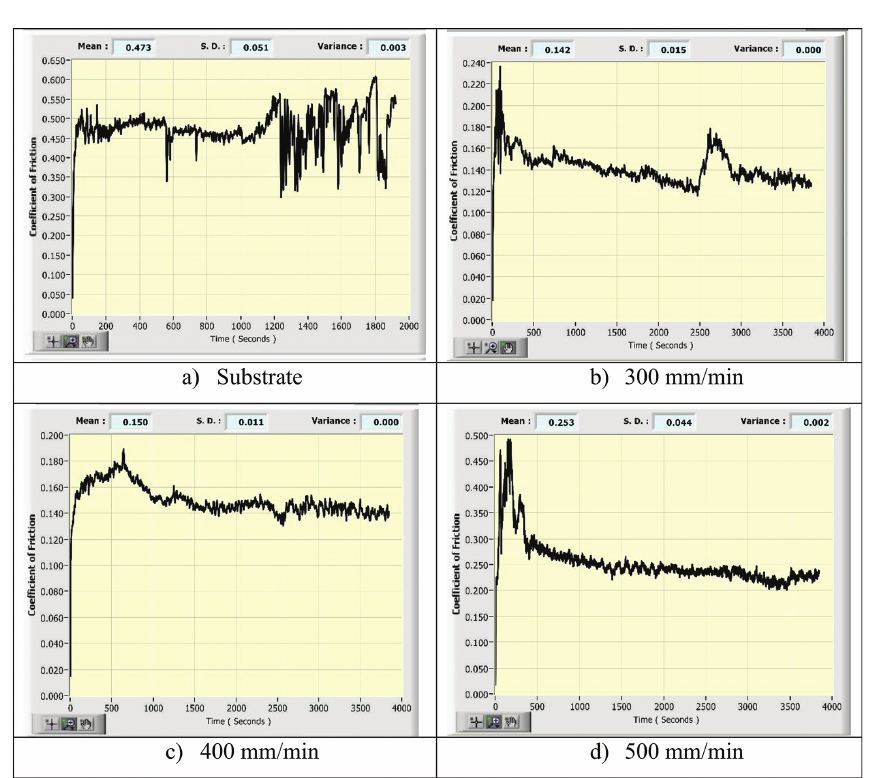
Figure 15: Coefficient of friction graphs for substrate and different travel